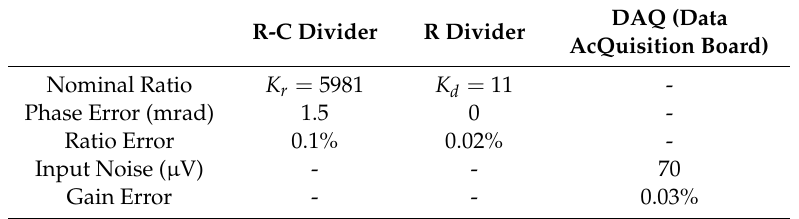
Table 1. Nominal accuracy specifications of the items which compose the calibration setup.